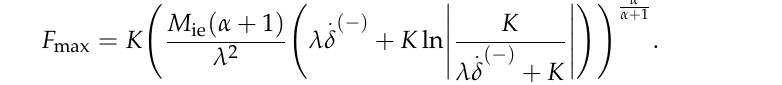
Figure 6. Errors with different restitution coefficients ( K = 10 9 N/m 1.5 ,